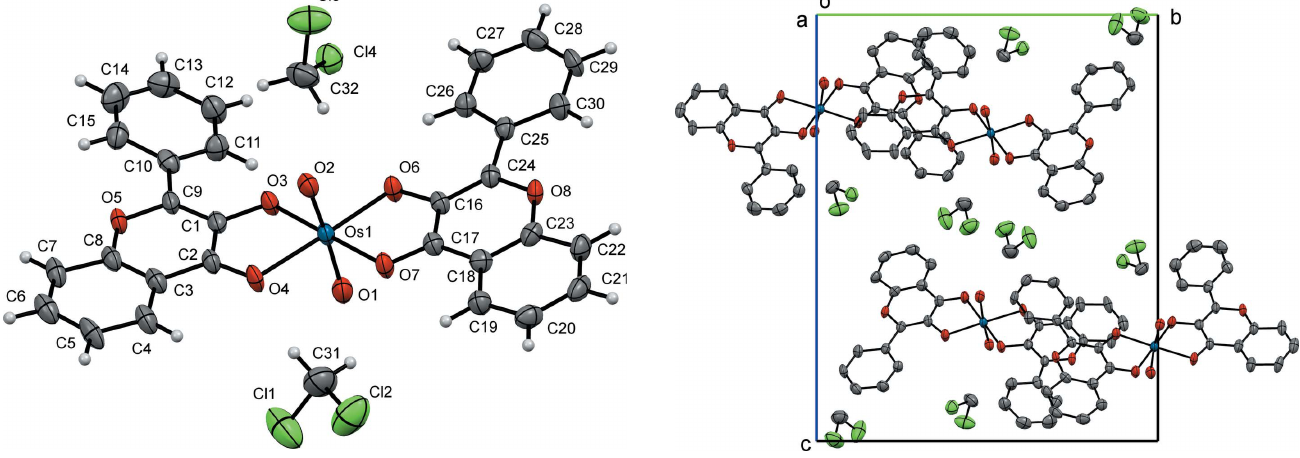
Figure 2 Crystal packing diagram of title compound viewed along the a axis. H atoms have been omitted for clarity.